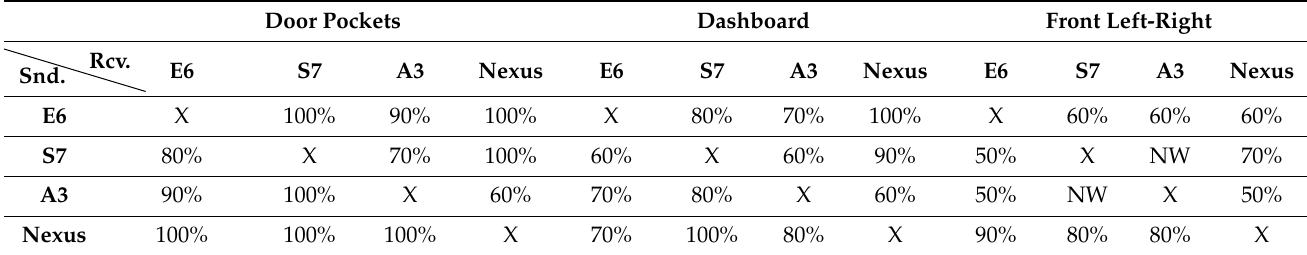
Table 6. Pairing success rate for in-vehicle experiments (8.7–12 KHz range).